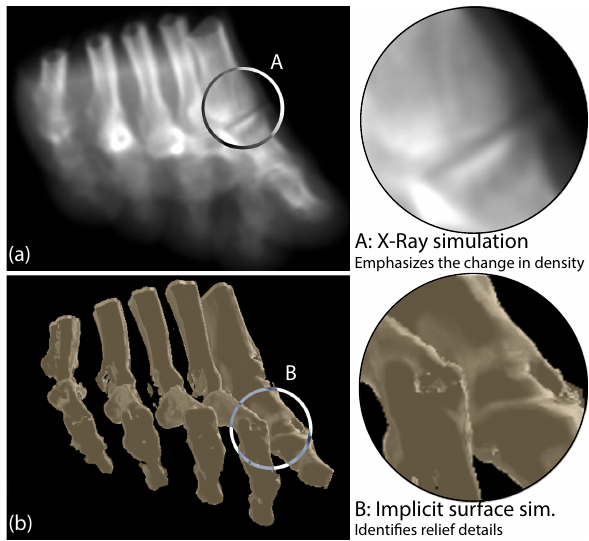
Figure 17. Two volume rendering on a ( x, y, z ) medical datacube: (a) X-Ray-like rendering model and (b) simulation of implicit surfaces.